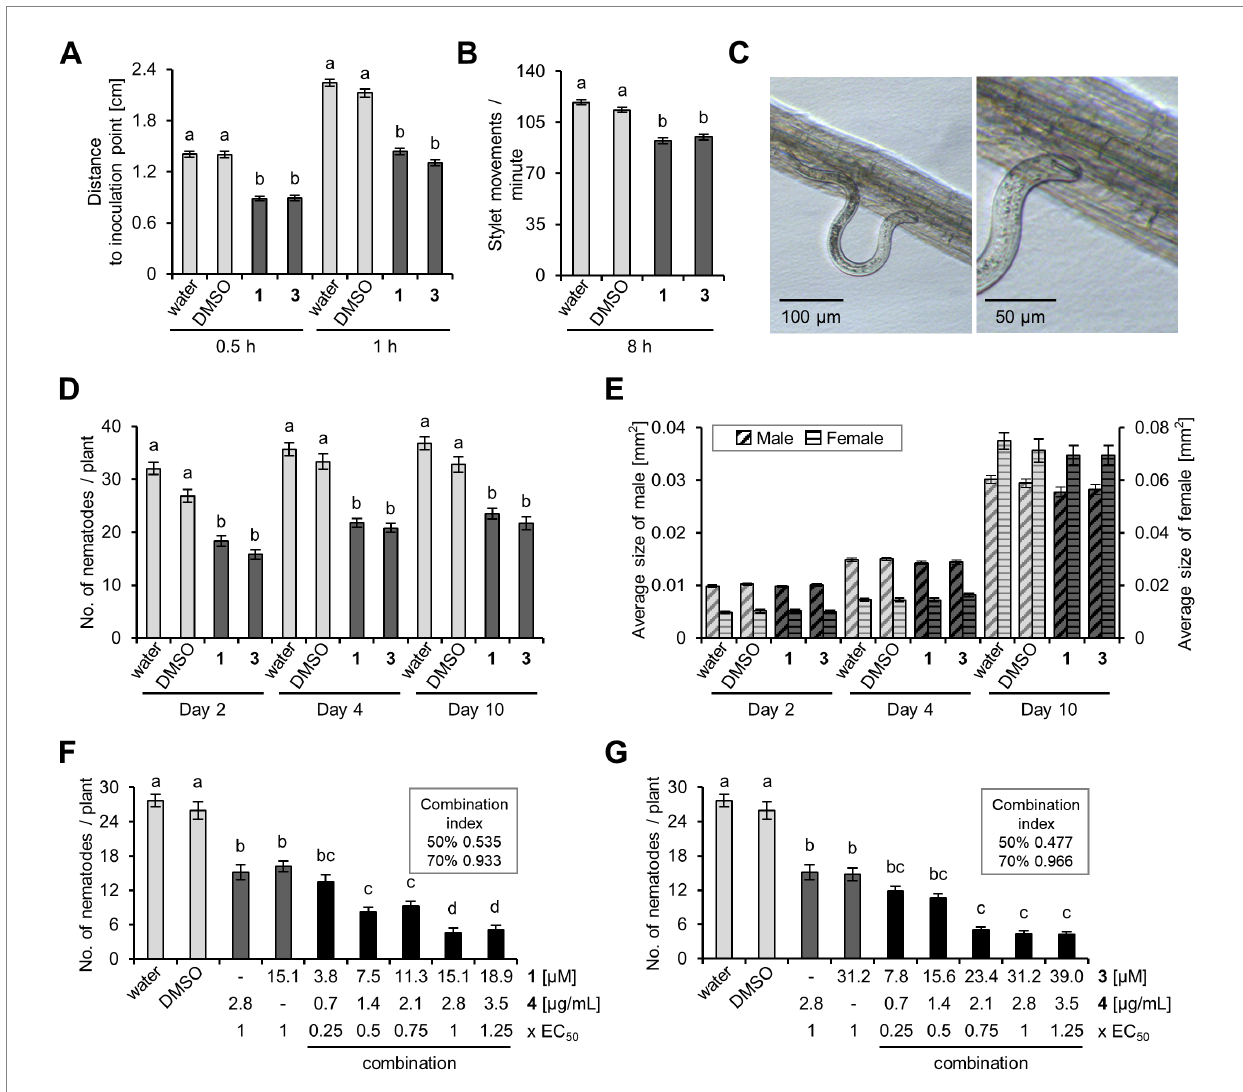
FIGURE 6 Prodiginine impact on Heterodera schachtii fitness parameters, plant parasitism, and combined activity with di-rhamnolipids. (A) H. schachtii J2 motility, assessed as distance to an inoculation point after incubation. (B) Stylet thrusting at Arabidopsis thaliana roots, assessed as movements/min. (C) A. thaliana root with an invading J2. (D) Nematode infection rate at A. thaliana , investigated at different time points after inoculation. (E) Nematode size development, evaluated during 10 days after inoculation. (F,G) The combined effect of prodigiosin ( 1 ) and di-rhamnolipids ( 4 ) as well as hydroxylated prodiginine 3 and di-rhamnolipids ( 4 ), respectively, was assessed at 10 days after inoculation. Combination indices were calculated using ‘CompuSyn’. Results are expressed as the mean ± standard error of at least three biological replicates [n ≥ 614 (A) ; n = 40 (B) ; n = 56 (D); n ≥ 70 (E) ; n ≥ 20 (F) ; n ≥ 22 (G) ]. Different letters indicate statistically significant differences among treatments according to Dunn’s Method ( p < 0.05). EC 50 is the effective concentration that causes a reduction of nematode infestation of A. thaliana by 50%. Prodigiosin ( 1 ) and hydroxylated prodiginine 3 were used at their EC 50 concentration in A , B , D